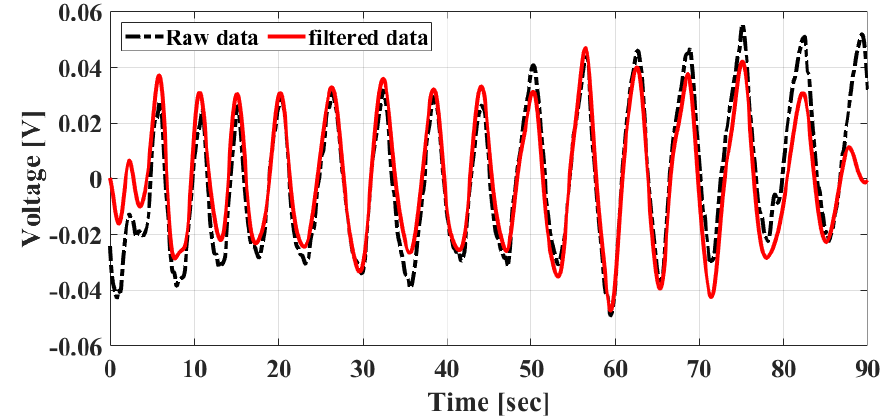
Figure 9. Raw and filtered waveforms measured at a distance of 1 m using the proposed radar.